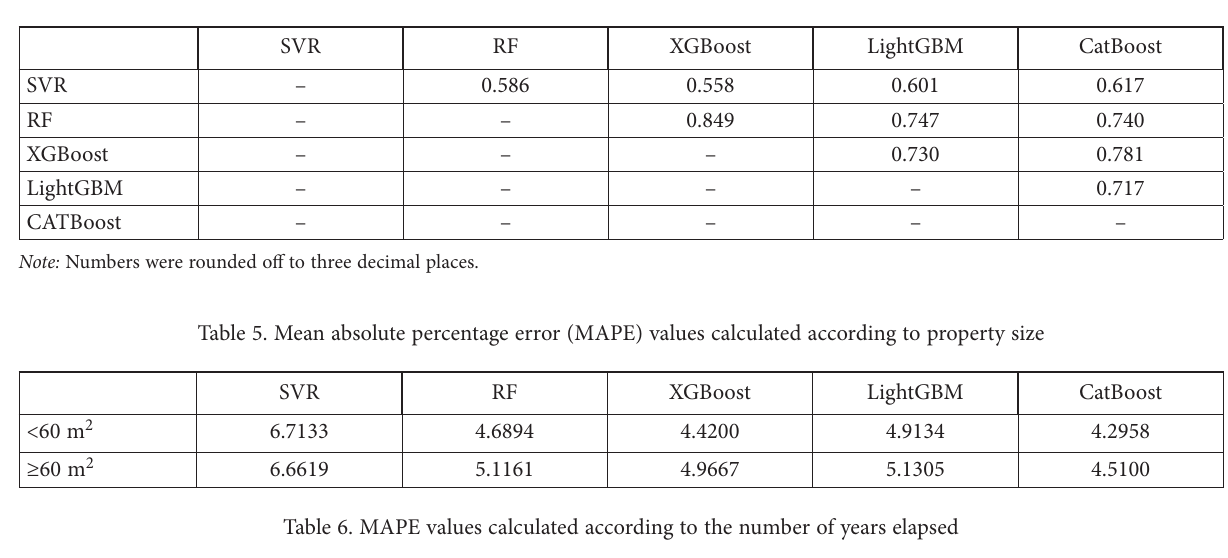
Table 4. Pairwise correlation coefficients for percentage error